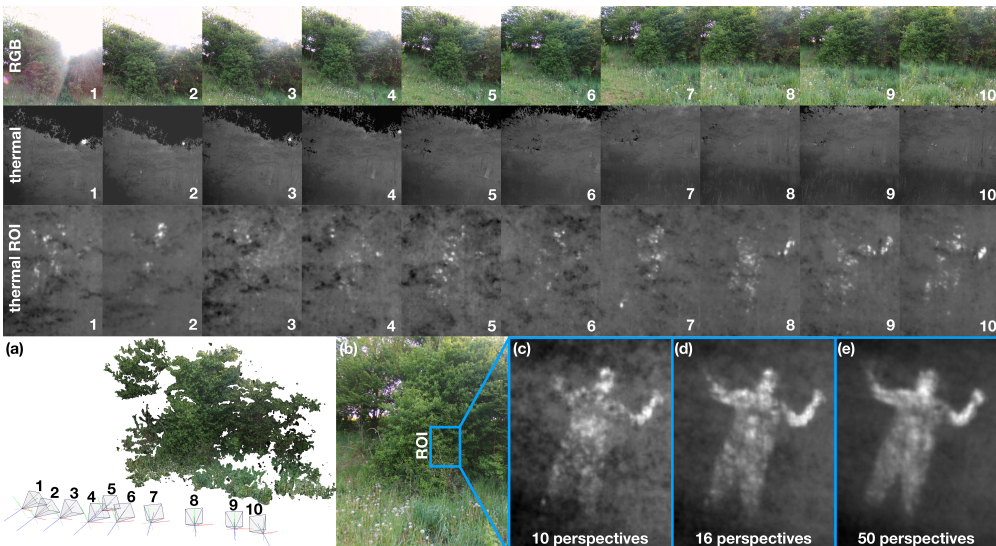
Figure 1. RGB images ( first row ) and corresponding tone-mapped thermal images ( second row ), close-up of thermal images within region of interest ROI ( third row ), results of pose estimation and 3D reconstruction ( a ), RGB image from pose 5 with indicated ROI ( b ), TAOS rendering results of ROI for 10 perspectives ( c ), 16 perspectives ( d ), and 50 perspectives ( e ). See also supplementary